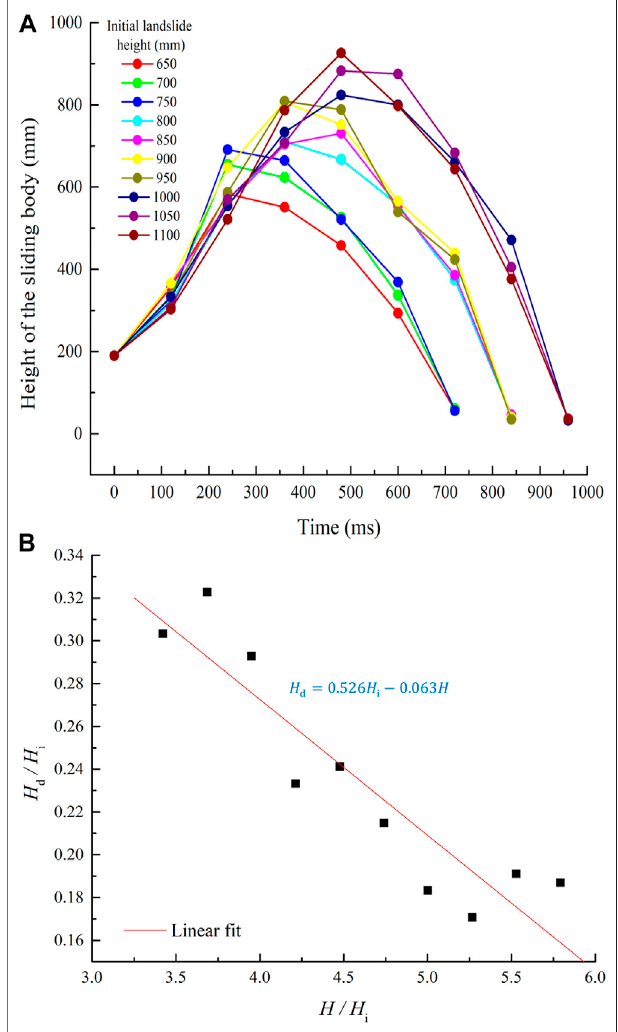
FIGURE 7 | (A) Variation in sliding body height during the landslide process and (B) height of